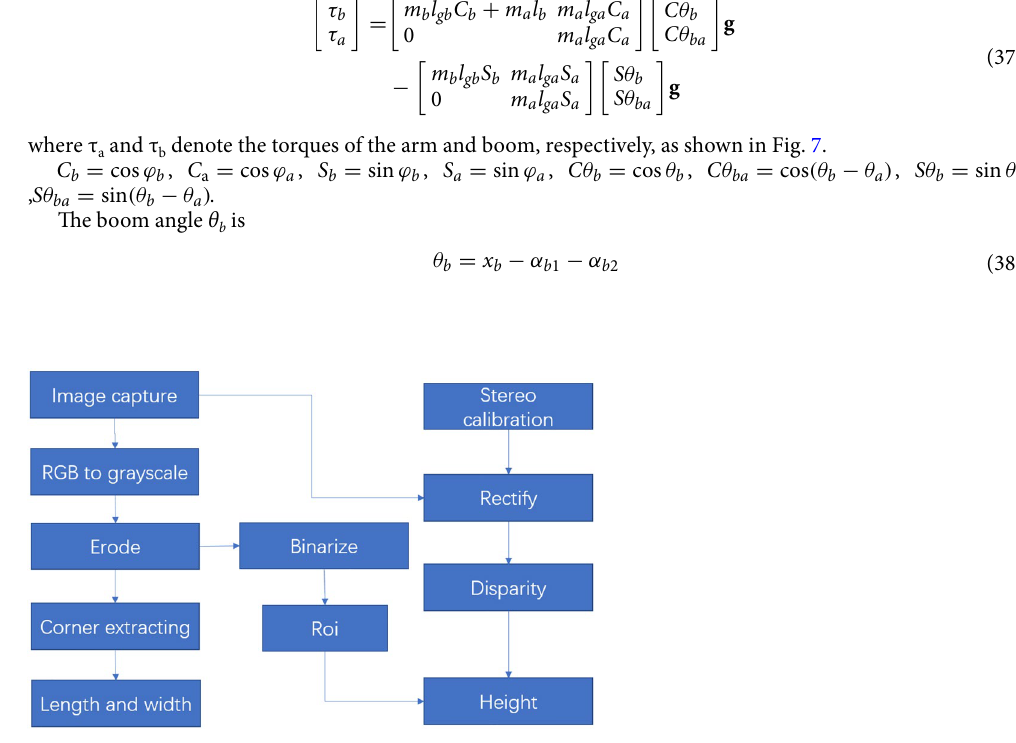
Figure 6. Image processing in computer